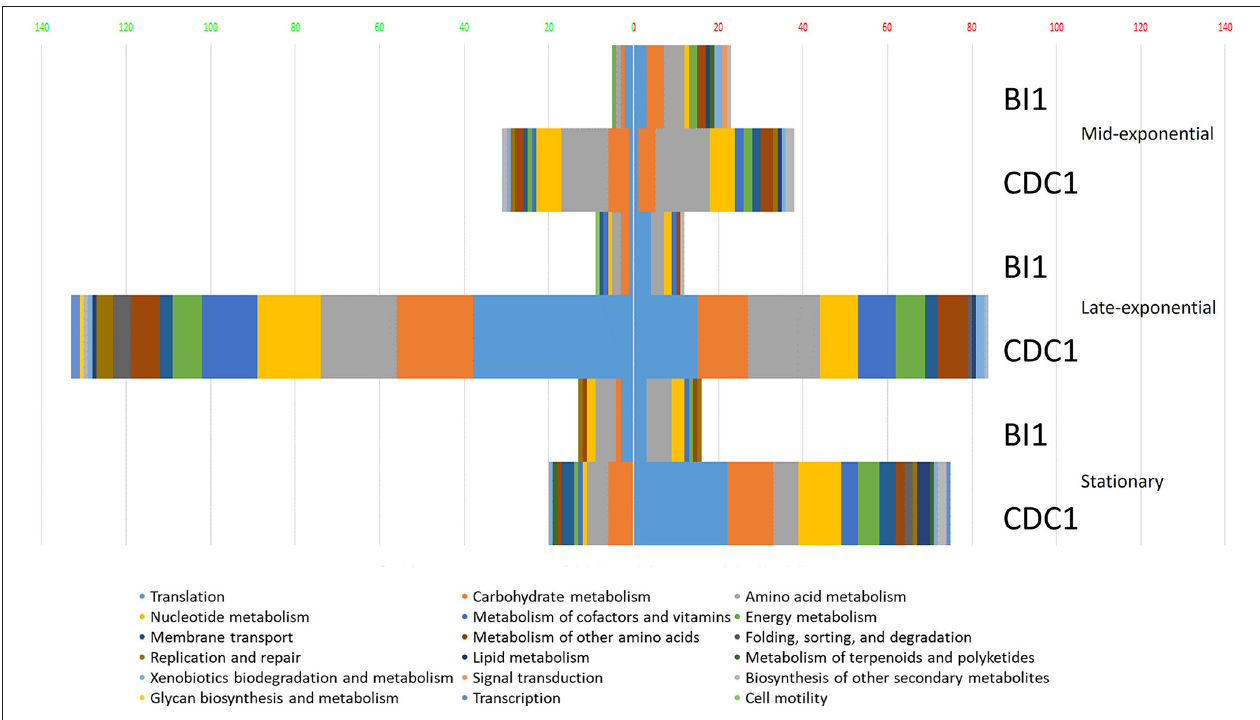
FIGURE 2 | Functional classification of dysregulated proteins in C. difficile strains BI-1 and CDC1 resulting from sigL disruption. Functional classification analysis was performed on proteins identified as altered in sigL disruption mutants using an arbitrary fold change cut-off of 2. The x-axis is the number of dysregulated proteins. Numbers on the left in (green) are decreased in abundance, on the right (red) are increased in abundance. The colors of the columns represent different functional categories based on RAST classification